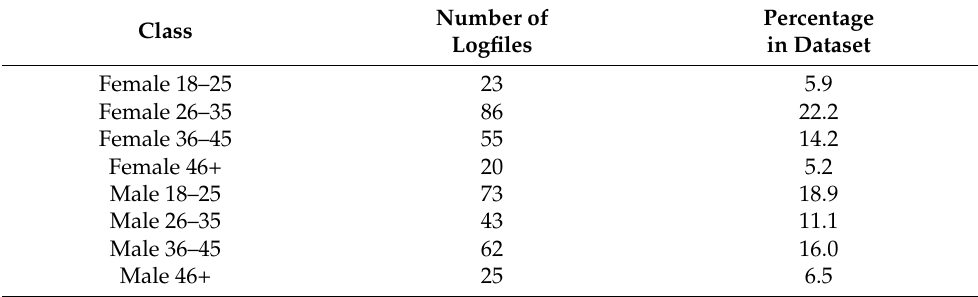
Table 2. Number of logfiles per